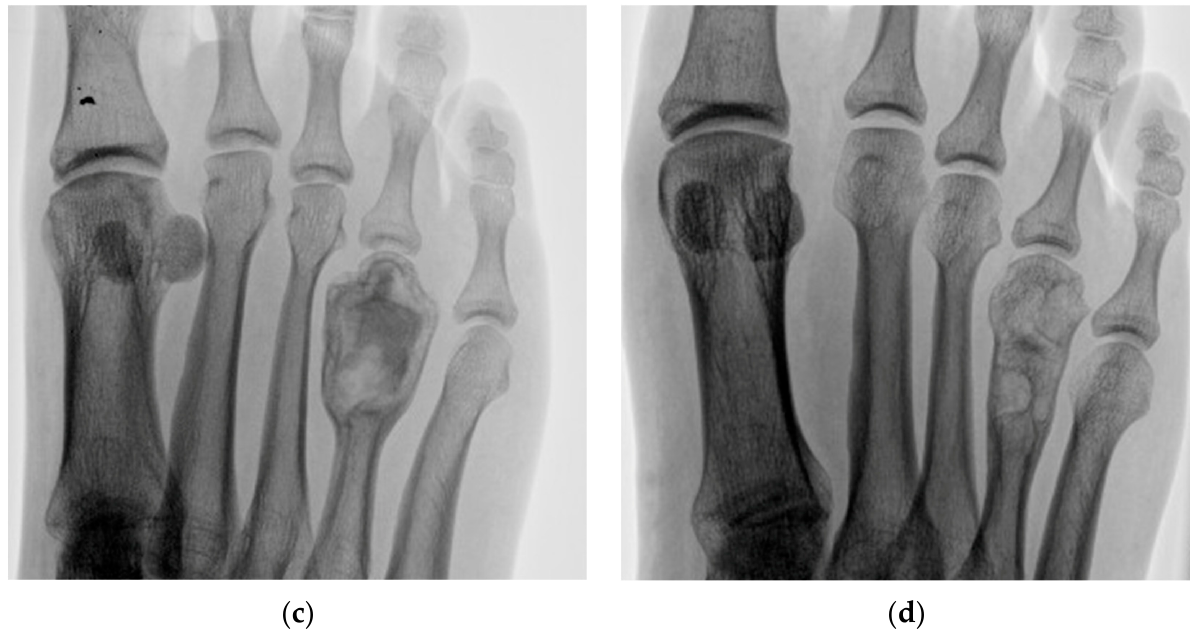
Figure 1. Dorsoplantar (DP) radiographs of right foot ( Case 1 ): ( a ) preoperatively, showing an aneurysmal bone cyst in the distal fourth metatarsal; ( b ) immediately postoperatively, following excision and curettage, with the contained defect filled with GeneX; ( c ) at 6 months follow-up, the GeneX shows partial resorption and there is progression of bone healing with cortical definition maintained; and ( d ) at 12 months follow-up, the GeneX has been completely resorbed and there is evidence of significant bone remodelling.